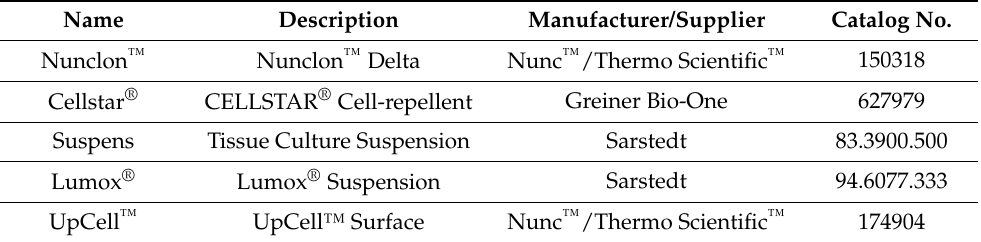
Table 1. Manufacturer-specific catalog numbers of the used culture